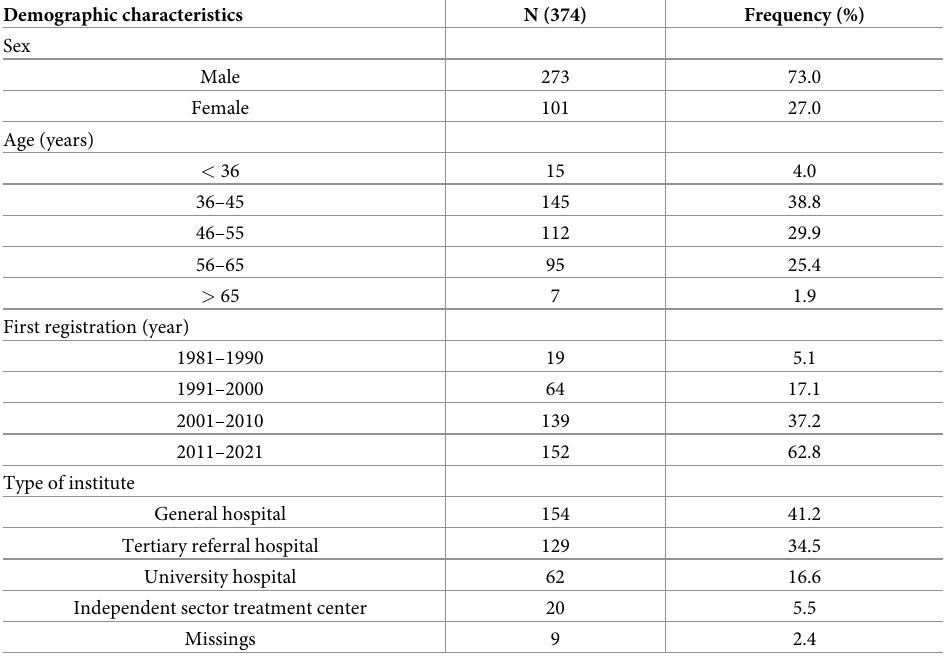
Table 1. Sample characteristics of 374 registered cardiologists in the Netherlands in